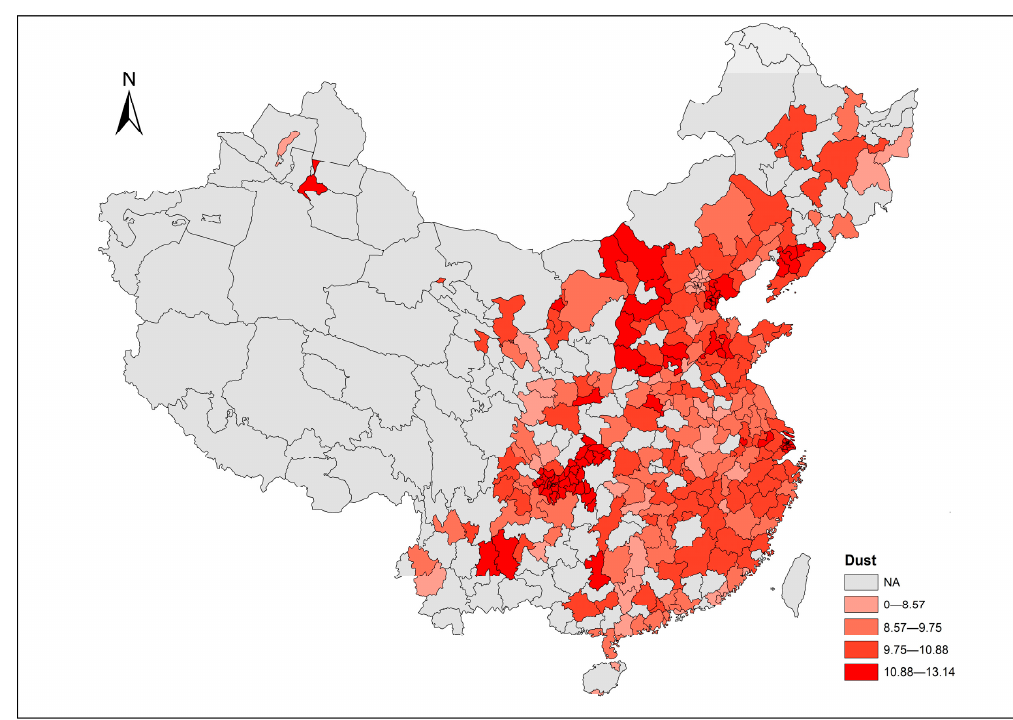
Figure 6. PM emission across cities in 2017. (cid:2870).(cid:2873)